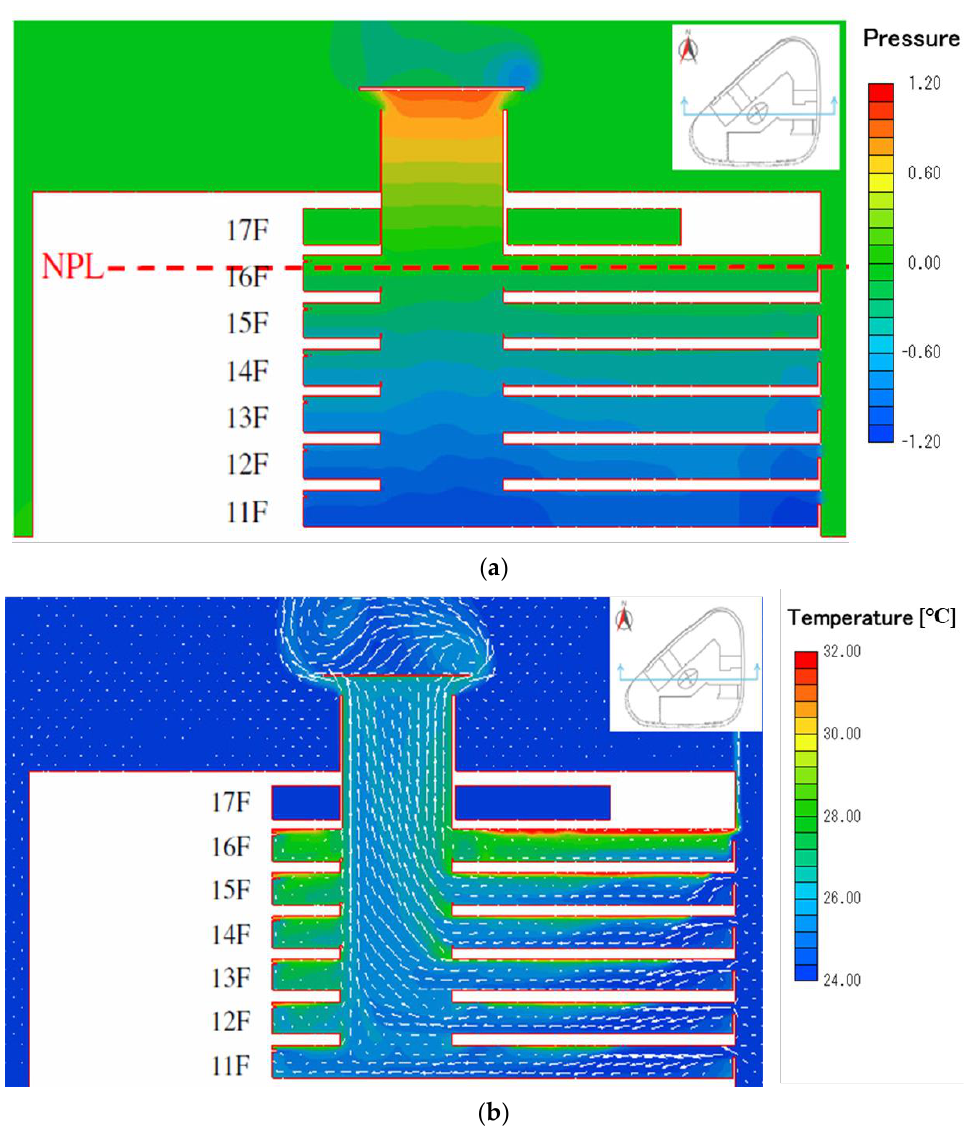
Figure 12. Simulation at 24 °C when both external air and cold air from office rooms are applied. ( a ) Pressure distribution. ( b ) Temperature contour with flow vectors.